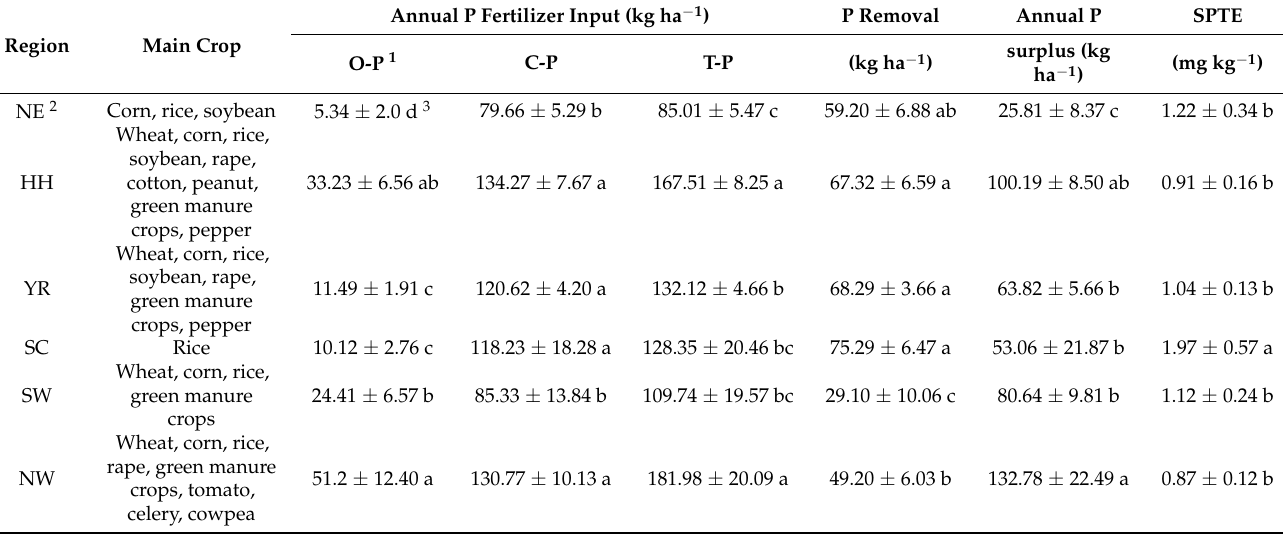
Table 2. Fertilizer P information at different